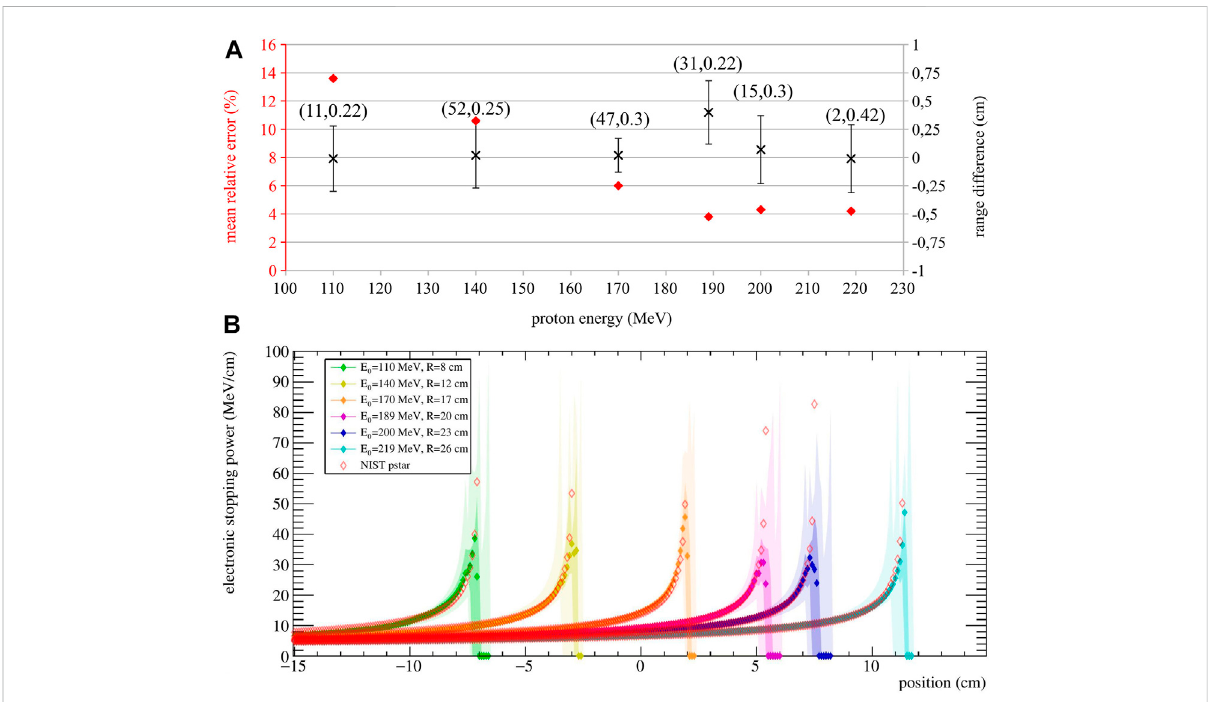
FIGURE 4 (A) Stopping power MRE (red diamond) and range difference Δ (cid:2) R (black cross, averaged over 10 realizations) for each simulated energy. The chosen iteration and threshold, optimized for the stopping power estimation, are reported as ( k , T ). The range standard deviation σ Δ R is displayed as error bars. (B) Median of stopping power estimations for 10 realizations per energy. Their quartiles (0%, 25%, 75% and 100%) are reported in different color shades. The NIST reference stopping power for each energy averaged over 1 mm bins is also reported (empty diamonds). The expected ranges for the considered energies are stated in the